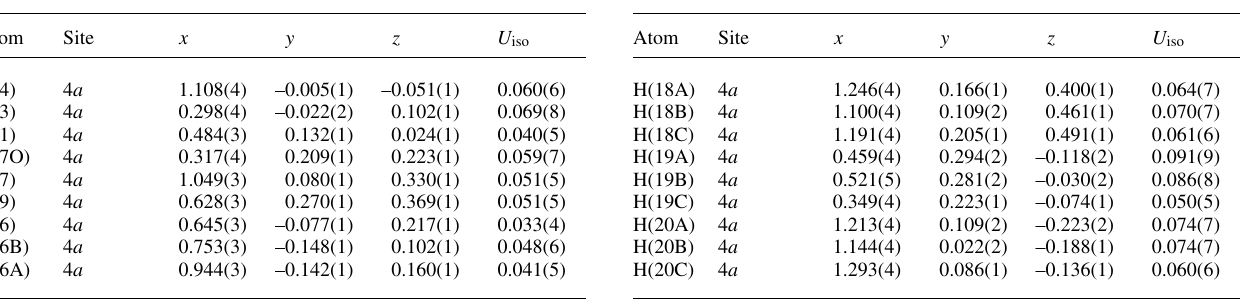
Table 2. Atomic coordinates and displacement parameters (in Å 2 )